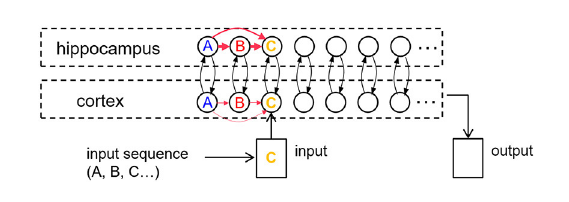
FIGURE1 An illustration of the cortico-hippocampal memory model. Encoding, consolidation, and recall of sequential experiences are simulated. When a percept is entered into the input register, it energizes a matching cortical item. If a matching cortical item is not found, a new one is allocated. Activation is spread from cortical items to their counterparts in hippocampus and back to the cortex through fixed inter-module links or bi-directional projections (black arrows). Directional intra-module links (red arrows) develop between any simultaneously active items within each memory module as a function of their dynamic activations. The illustration shows an input three-item sequence (“A”-“B”-“C”) with directional links having formed first from “A” to “B.” When “C” is encountered, if “A” and “B” are still active, links are instantiated from “A” to “C” and from “B” to “C.” The learning rate in the hippocampus is an order of magnitude faster than